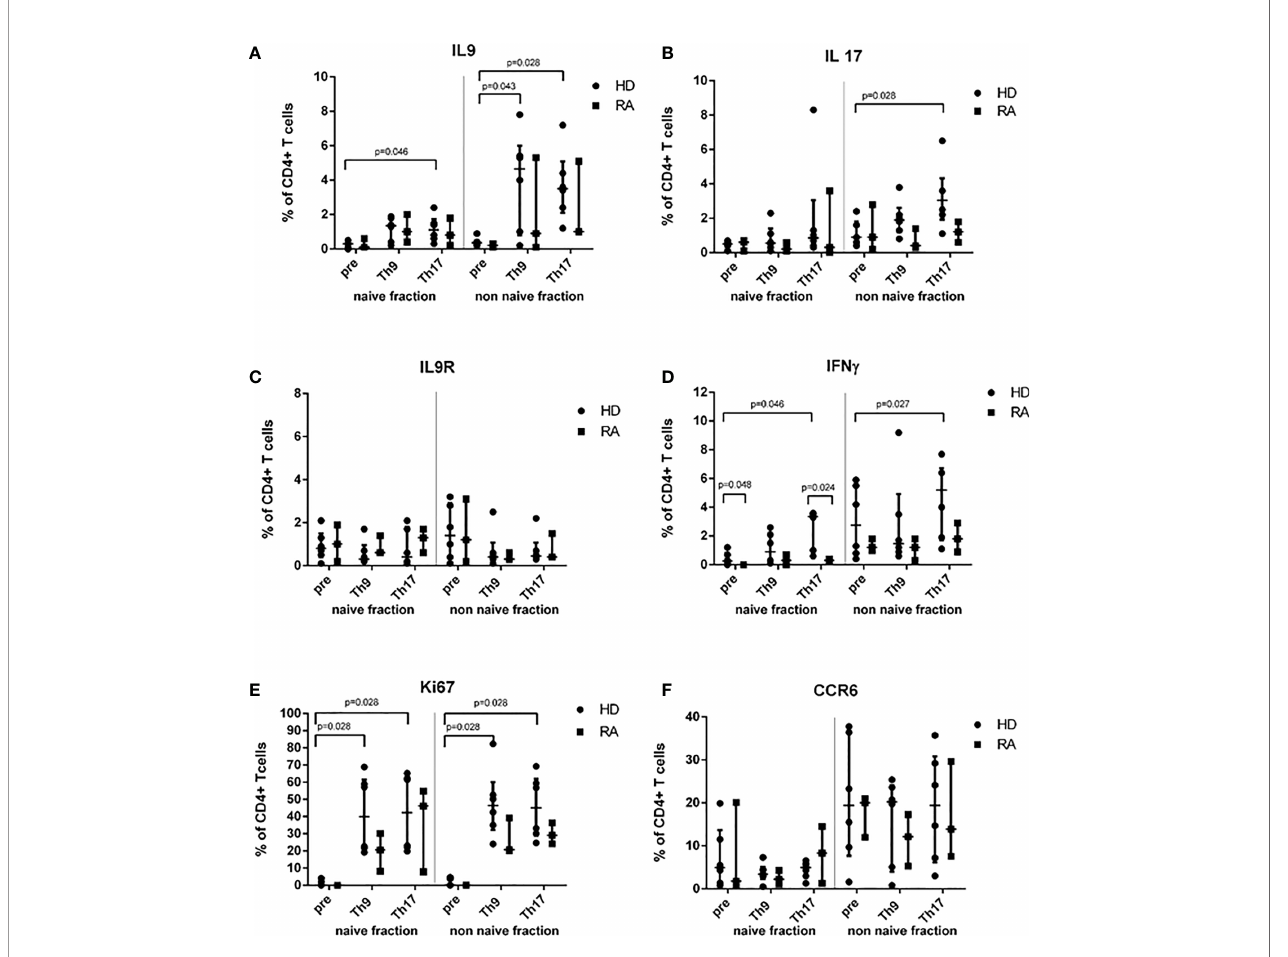
FIGURE 1 | Proportions of cytokine-, IL-9R-, Ki67- or CCR6+ T cells before (pre) stimulation and after 3d Th9- or Th17-stimulation in healthy donors (HD) and rheumatoid arthritis (RA) patients. Percentages of IL-9+ (A) , IL-17+ (B) , IL-9R+ (C) , IFN g + (D) , Ki67+ (E) and CCR6+ (F) cells are shown in the naive and non-naive fraction of CD4+ peripheral T cells which were investigated before cell culture (pre) and after 3d cell culture under Th9- or Th17-stimulating cytokine conditions in lymphocytes derived from patients with rheumatoid arthritis (RA) and healthy donors (HD) by fl ow